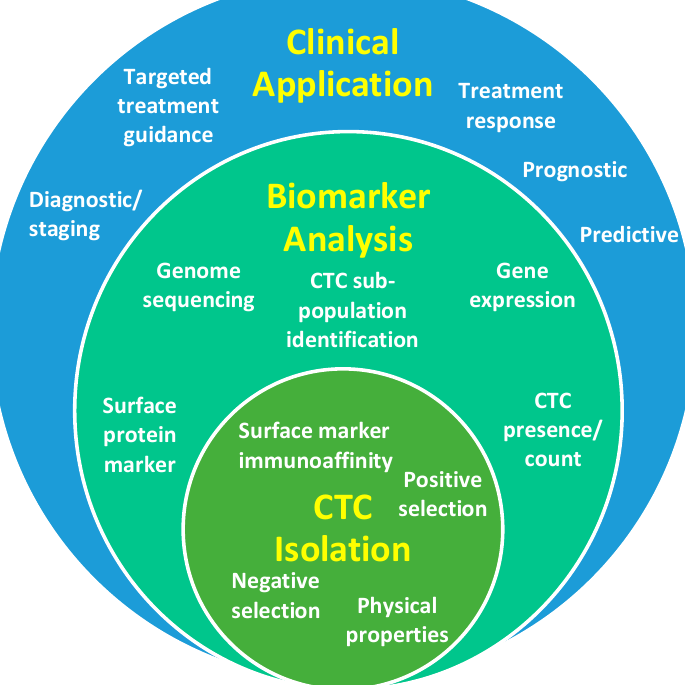
Figure 1. Diagrammatic representation of the relationship between circulating tumour cell (CTC) isolation strategies, biomarker outputs and clinical applications.